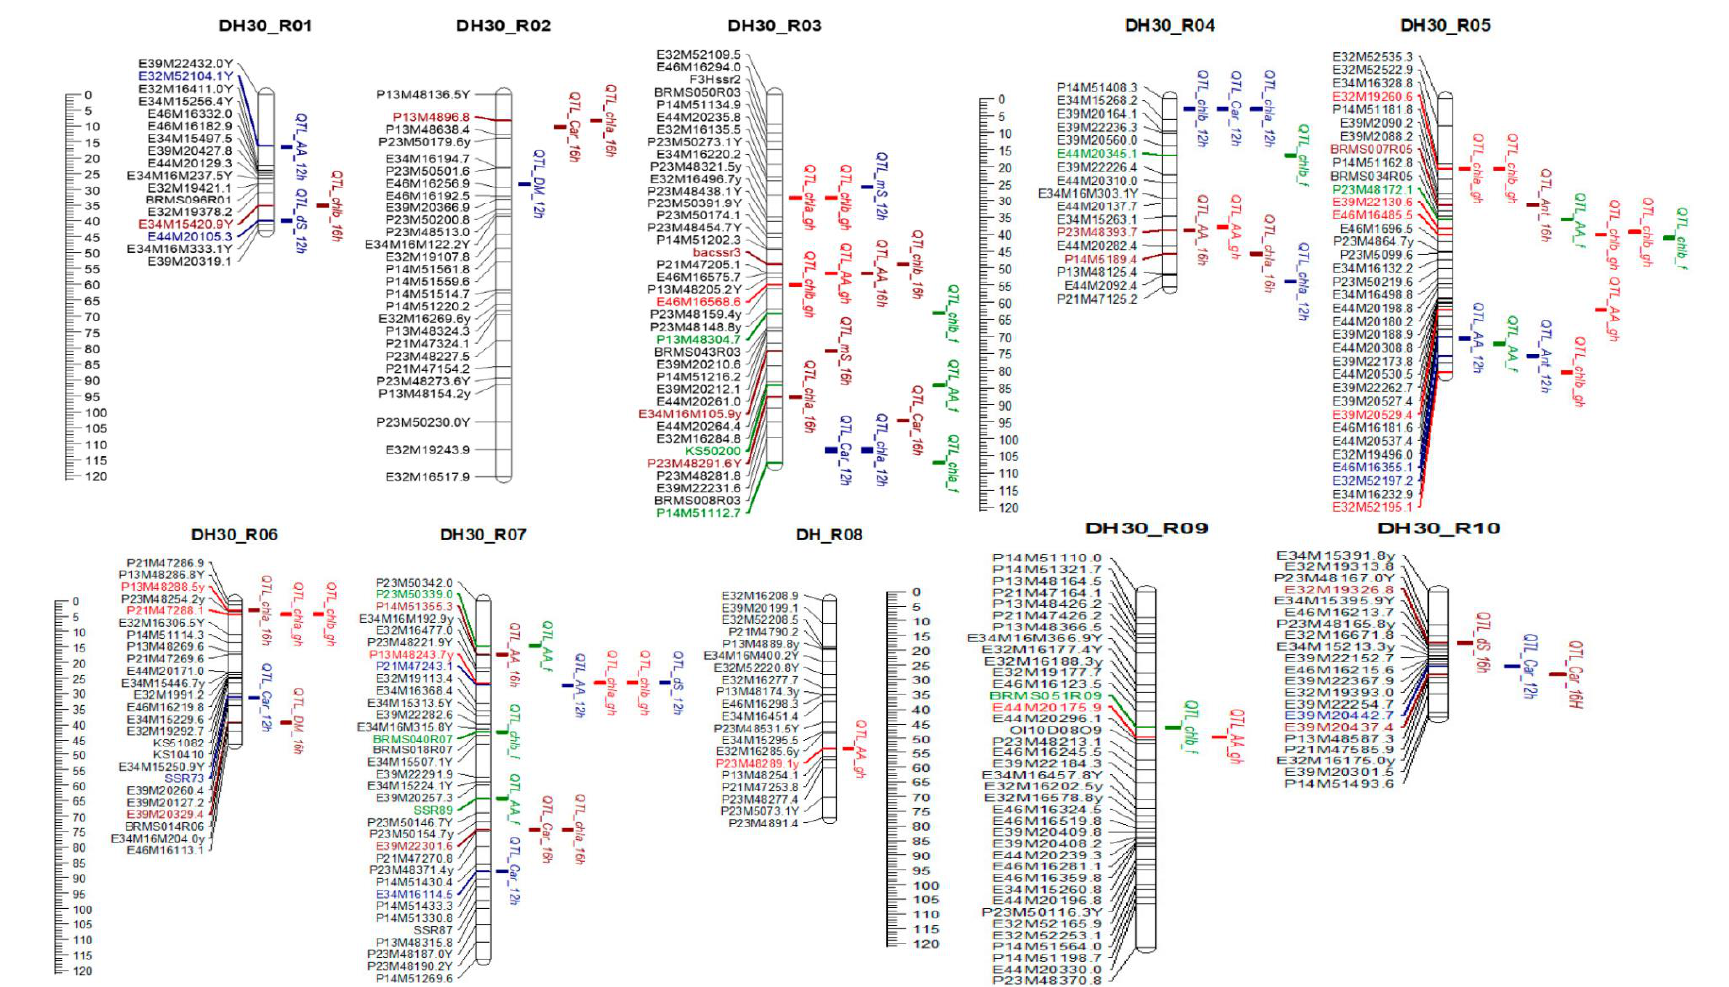
Figure 3. Mapping of QTLs determining expression of biochemical traits of in Brassica rapa L. (DH 30): 12 h — AFI experiment, light culture 12 h; 16 h — AFI experiment, light culture 16 h; gh — VIR experiment, greenhouse; f — VIR experiment, field. Trait designations: AA — ascorbic acid, Car — carotenoids, chla — chlorophyll a , chlb — chlorophyll b , DM — dry matter, mS — monosaccharides, dS — disaccharides.